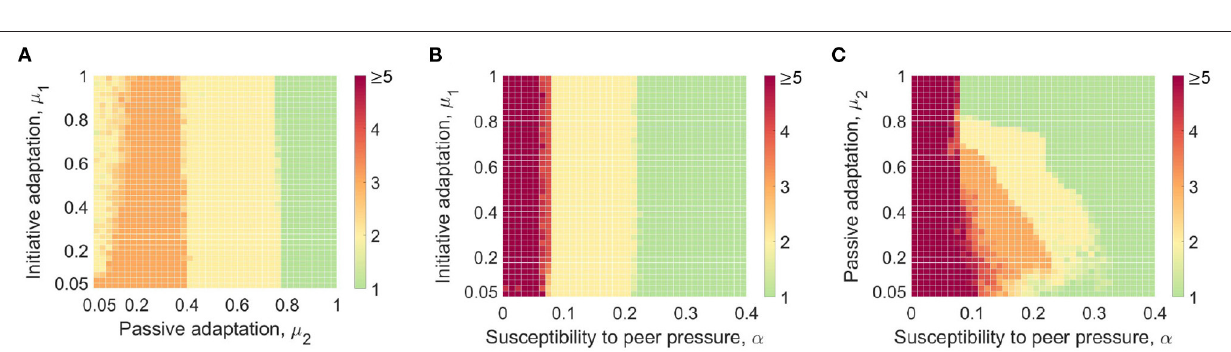
FIGURE 3 | Effect of initiative adaptation speed ( µ 1 ) and passive adaptation speed ( µ 2 ). Phase diagrams for the number of opinion clusters are shown under different combinations of (A) µ 1 and µ 2 , (B) µ 1 and α , as well as (C) µ 2 and α , respectively. We find that initiative adaptation speed hardly affects the number of opinion clusters, while passive adaptation speed shows a non-monotonous effect on it. Parameters: (A) δ = 0.05, α = 0.18, (B) δ = 0.05, µ 2 = 0.7, and (C) δ = 0.05, µ 1 =